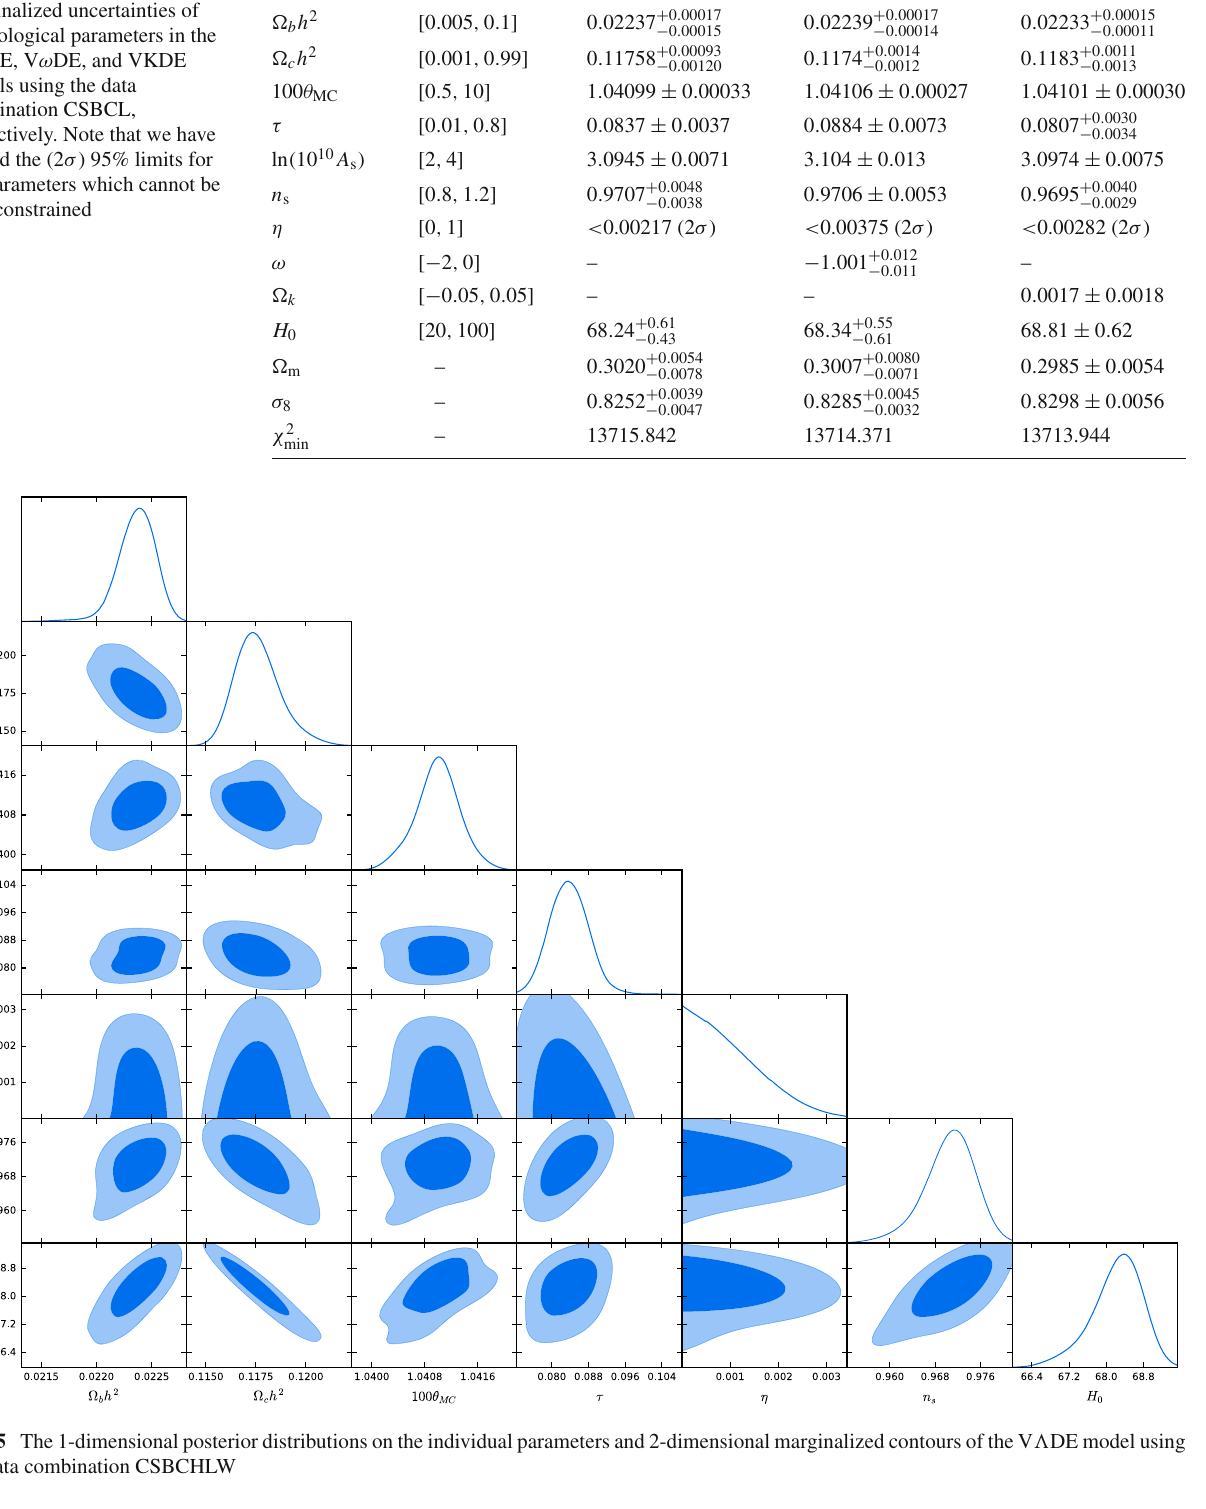
Table 1 The prior ranges and the best-fit values and 1 σ marginalized uncertainties of cosmological parameters in the V (cid:4) DE, V ω DE, and VKDE models using the data combination CSBCL,